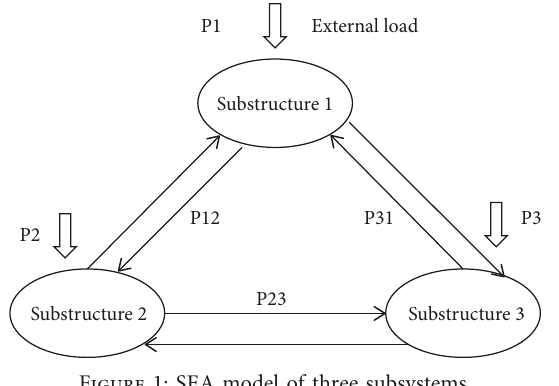
Figure 1: SEA model of three subsystems.